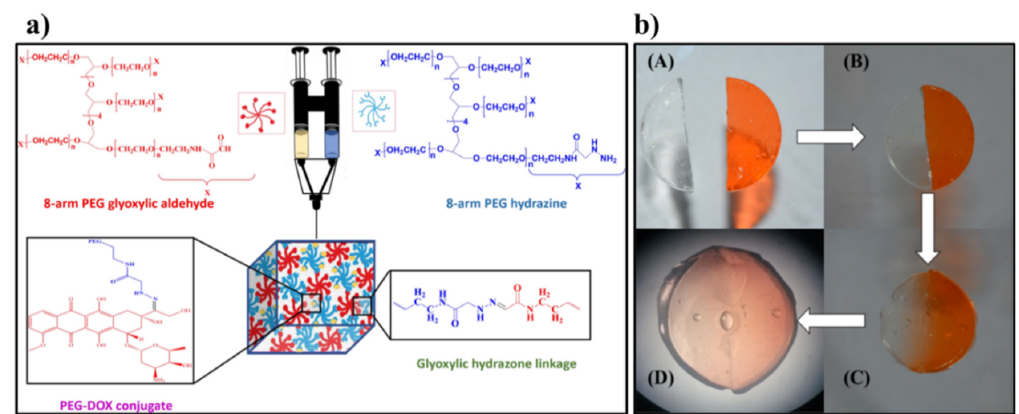
Figure 9. ( a ) Schematic representation of the steps involved in the fabrication of PEG Hydrogels from 8-arm PEG Glyoxylic Aldehyde, 8-arm PEG Hydrazine and 8-arm PEG Hydrazine partially modified with DOX, using hydrazone linkages. ( b ) Pictures showing the self-healing characteristic of hydrogels. ( A ) Freshly prepared hydrogel (with and without PEG − DOX loading). ( B , C ) Healing and diffusion of the conjugate at 0 and 2 h respectively. ( D ) Picture showing self-healed hydrogel with equilibrium drug diffusion after 6 h. (Reproduced with permission from Ref. [139] . Copyright 2019, The American Chemical Society).